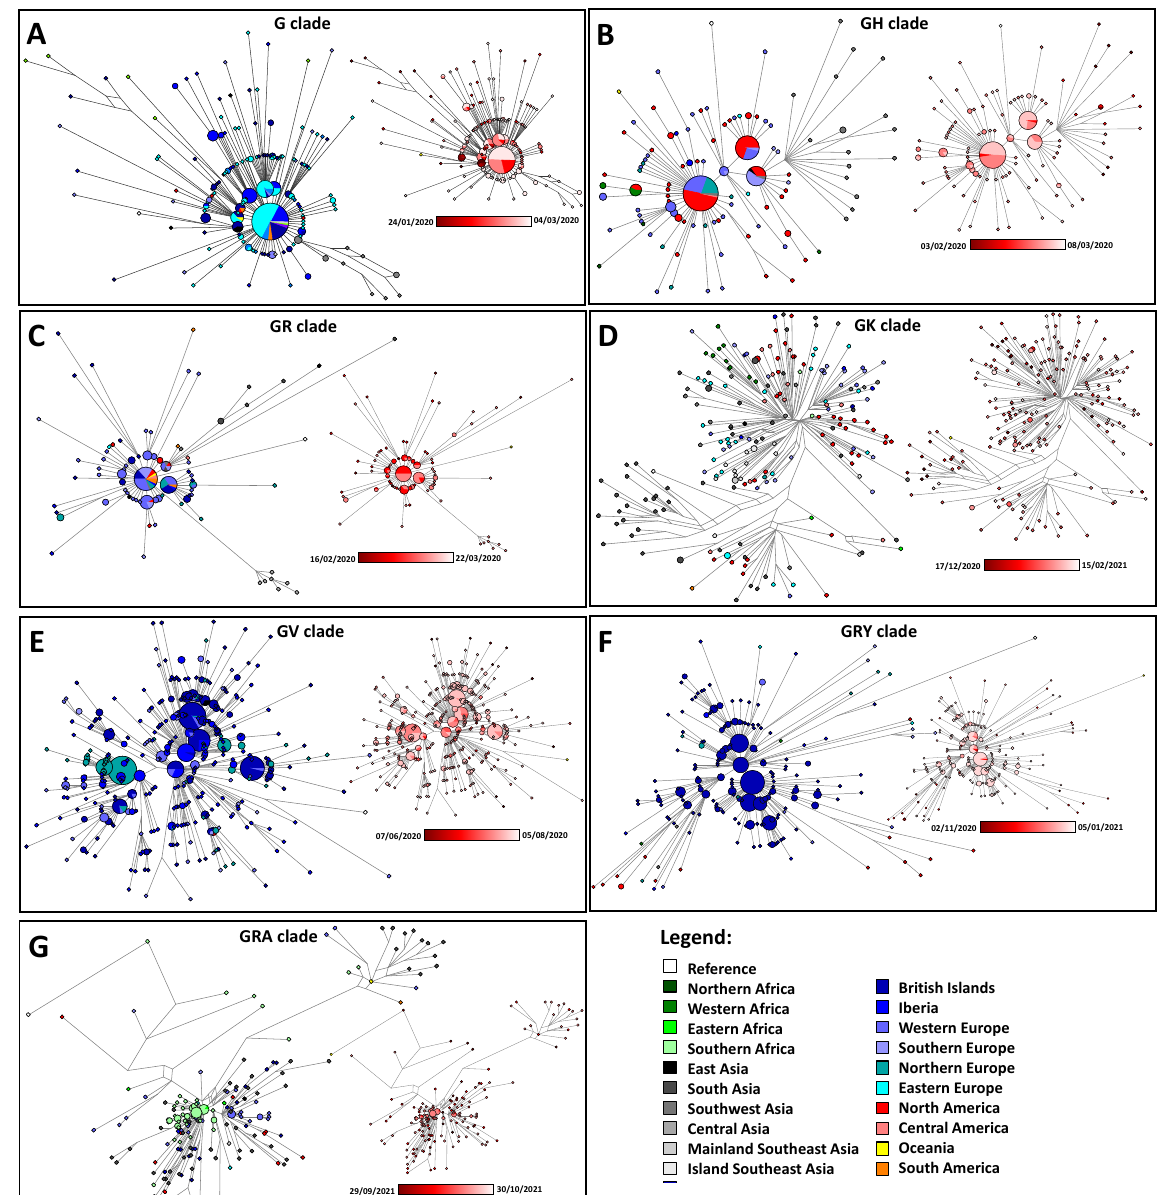
Figure 7. Median networks of the earliest deposited data of global SARS-CoV-2 lineages. The reference sequence was used as an outgroup in each. Networks are colored according to their geography and also according to time of collection. Networks were performed for clades G ( A ), GH ( B ), GR ( C ), GK ( D ), GV ( E ), GRY ( F ) and GRA ( G ).